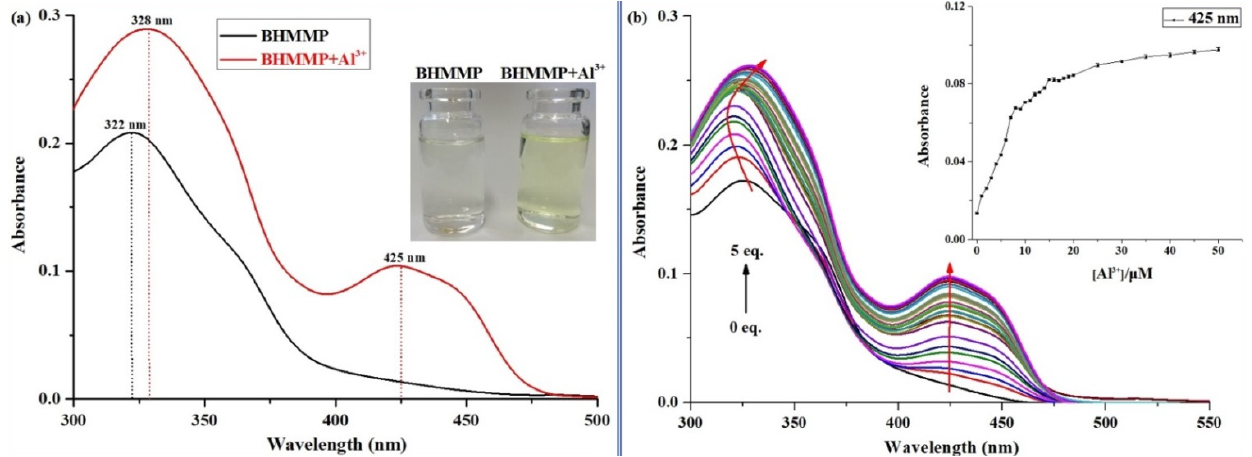
Figure 3. ( a ) UV–Vis absorption spectral of BHMMP (10 µM), in the absence and presence of Al 3+ (5 eq.). Inset: color change of BHMMP solution before and after addition of Al 3+ in ambient light. ( b )